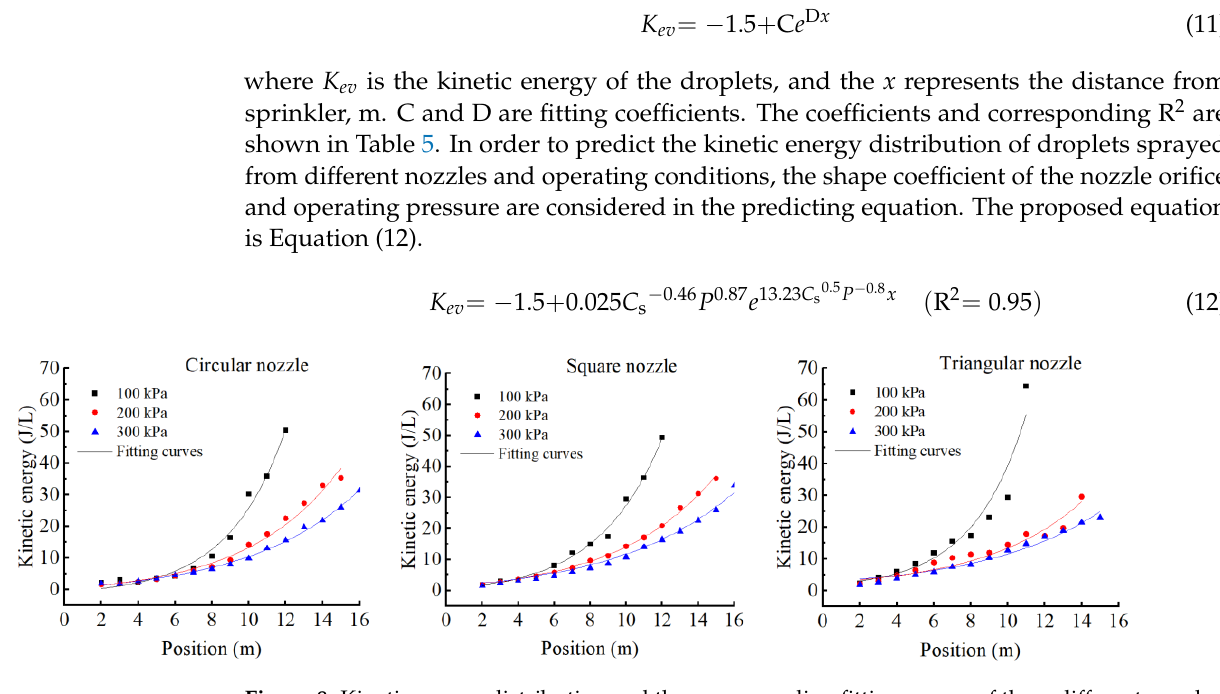
Figure 8. Kinetic energy distribution and the corresponding fitting curves of three different nozzles. Table 5. The exponential relationships between the kinetic energy and distance for different nozzles. Orifice